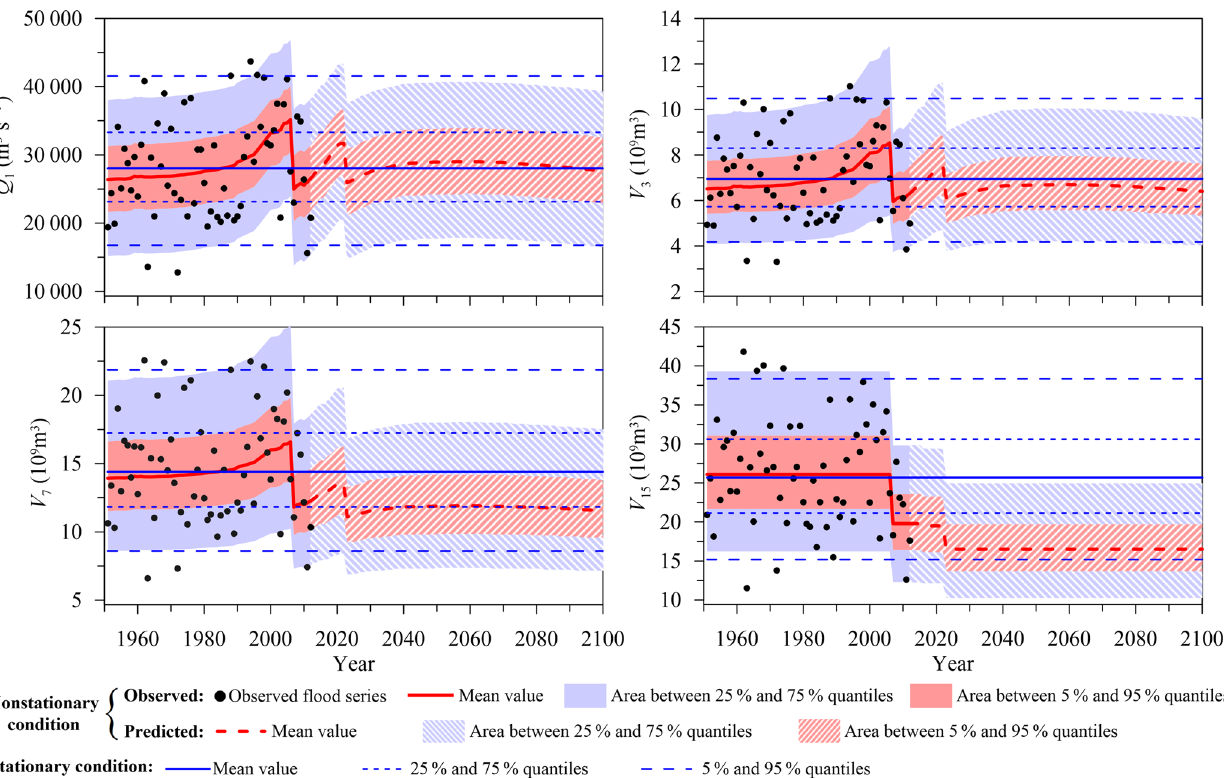
2023 after a larger reservoir named Datengxia is expected to be put into operation. After 2023, with no more reservoirs planned, the predicted mean values of Q 1 , V 3 and V 7 would be expected to reach their peaks in the mid-21th century fol- lowed by a slight declining trend because of a shrinking ur- ban population. Since V 15 was only related to RI, V 15 would show an abrupt decline in 2023 due to the regulation of the Datengxia reservoir. In general, the predicted nonstationary